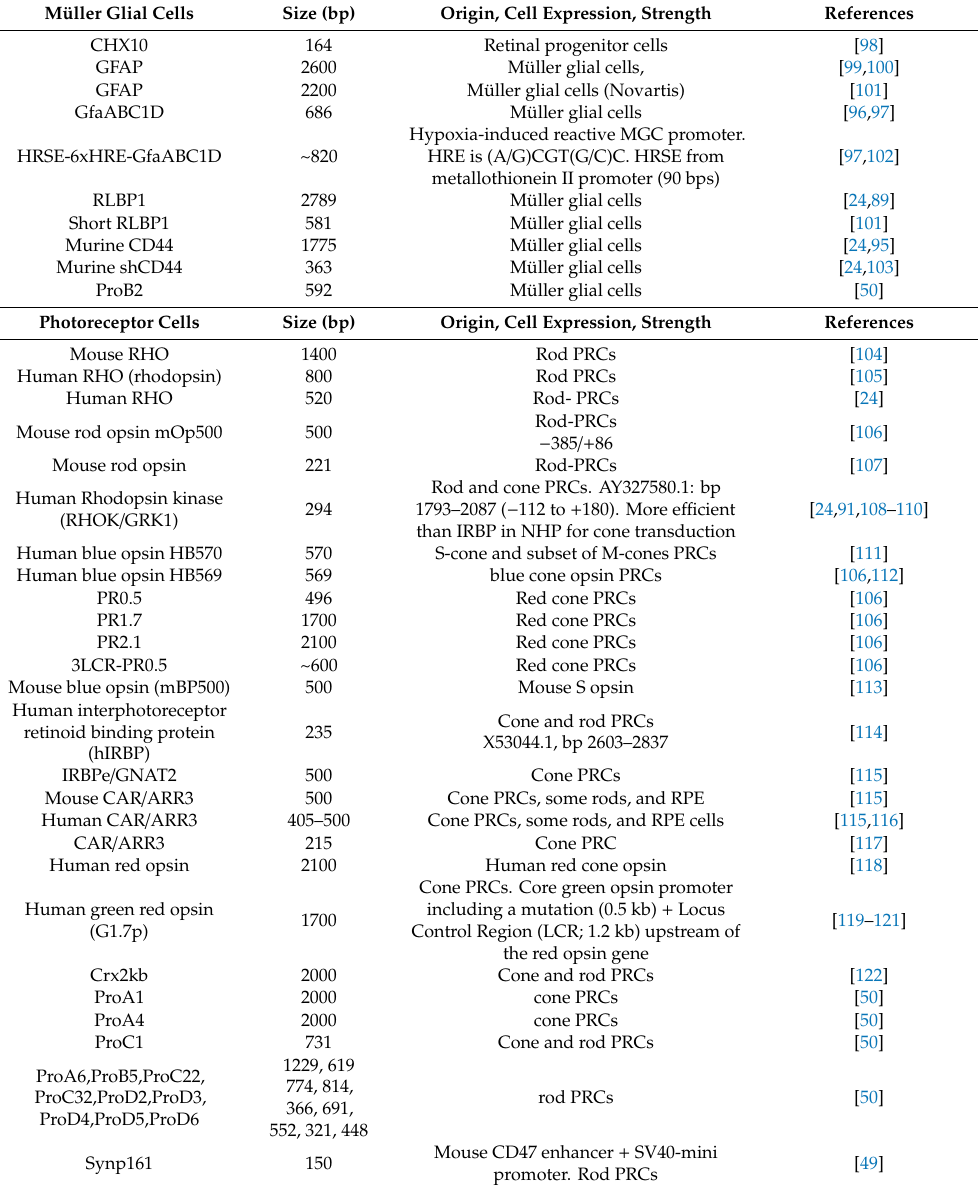
Table 3. Retina cell-specific promoters in rAAVs for ocular gene